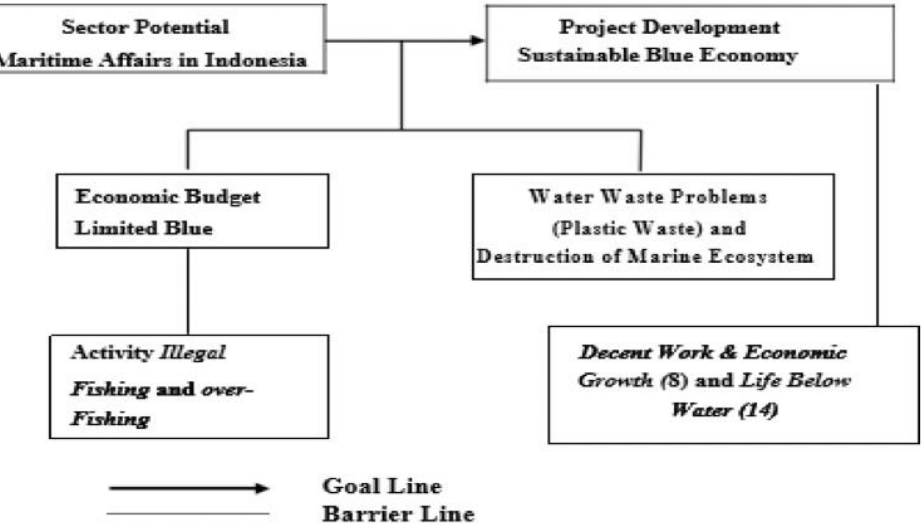
Figure 1: Writing Framework; Source: